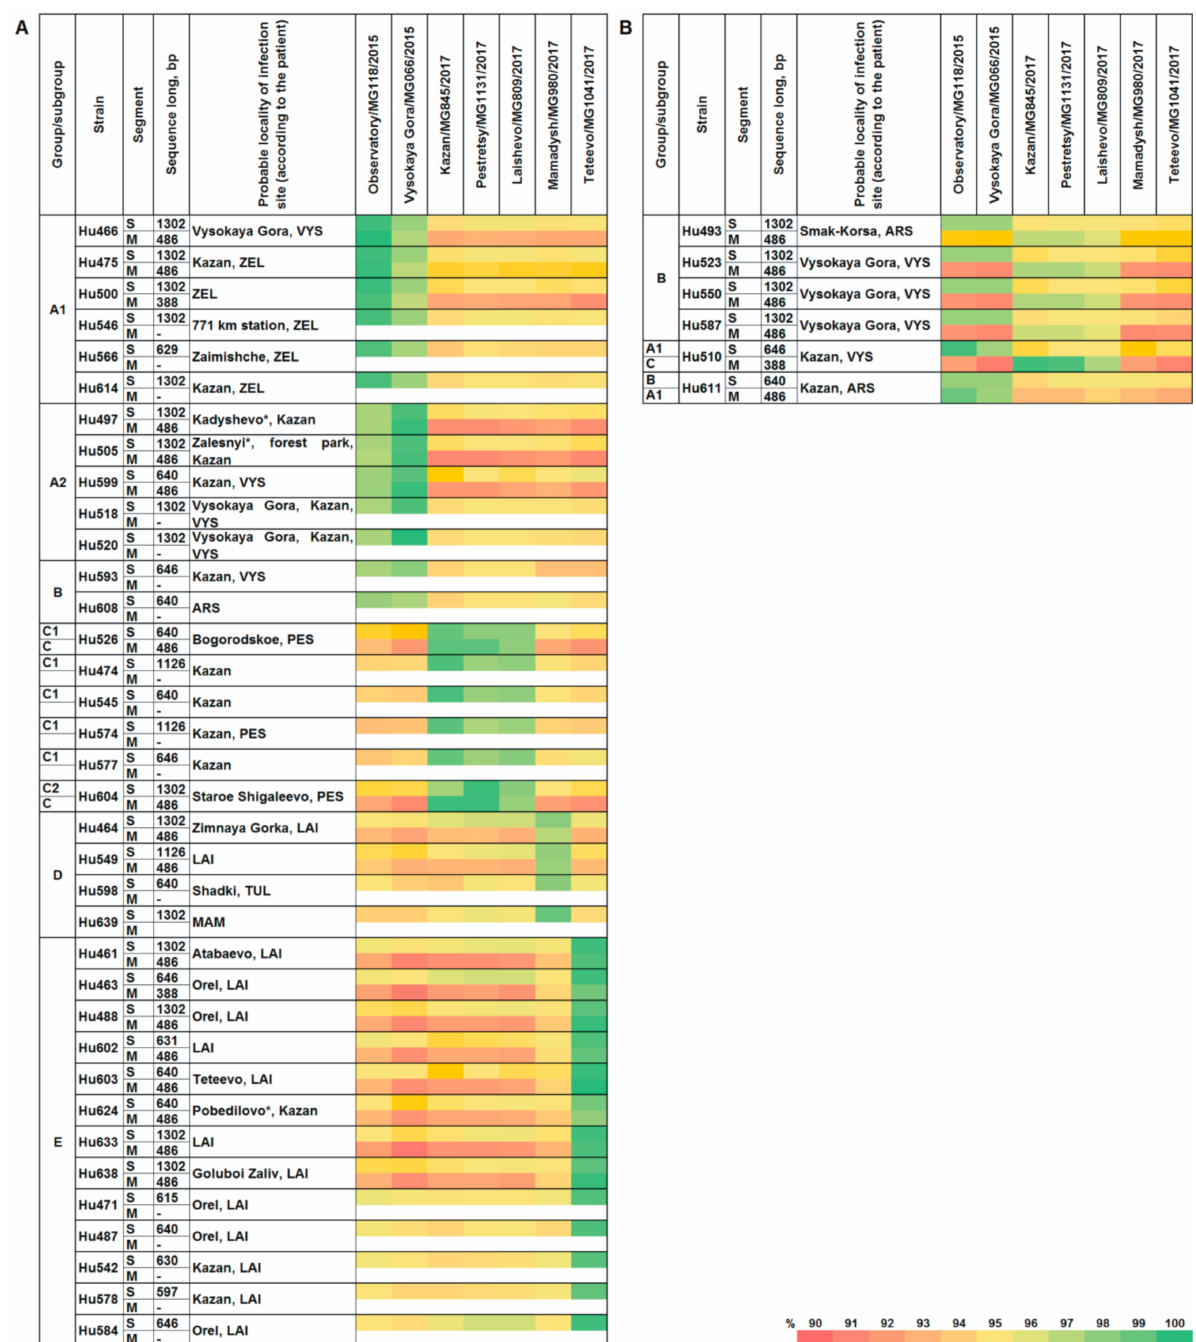
Figure 1. Identity of the S and M segment nucleotide sequences of the Puumala orthohantavirus strain obtained from hemorrhagic fever with renal syndrome patients and bank voles from several districts of the Republic of Tatarstan, %: ( A )—original genomes; ( B )—reassortant genomes. Districts of the